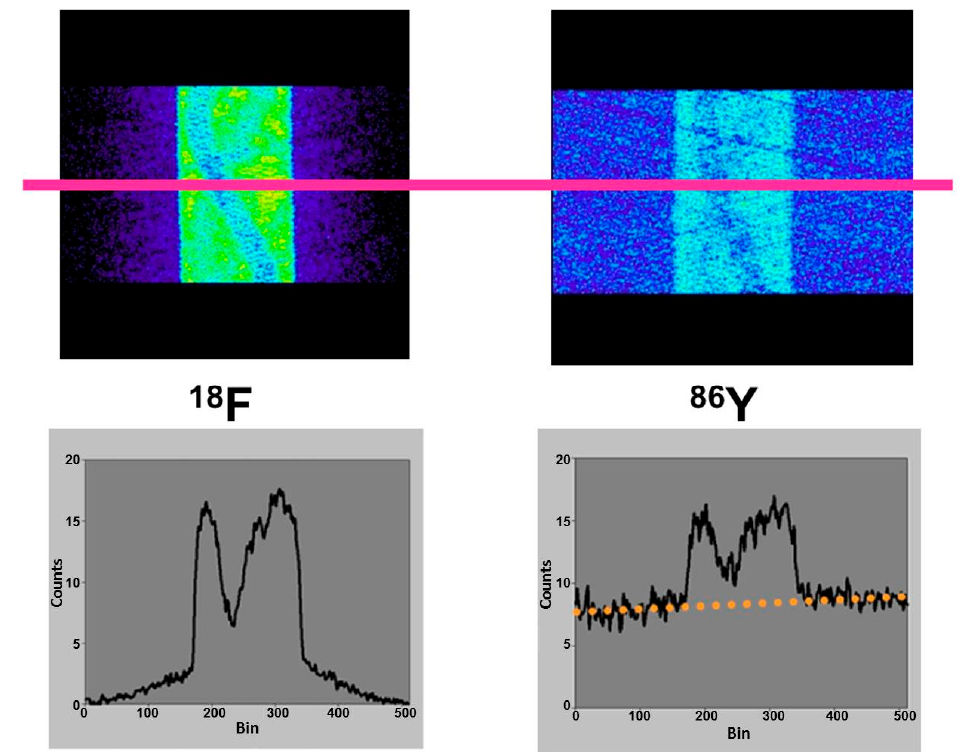
Figure 5. Top row: Sinograms of a rod phantom filled with 18 F or 86 Y. Bottom row: Corresponding profiles obtained along the pink line. If the phantom is filled with 18 F, there are zero counts at the edge of the field of view. If the phantom is filled with 86 Y, the gamma coincidences lead to a flat background.